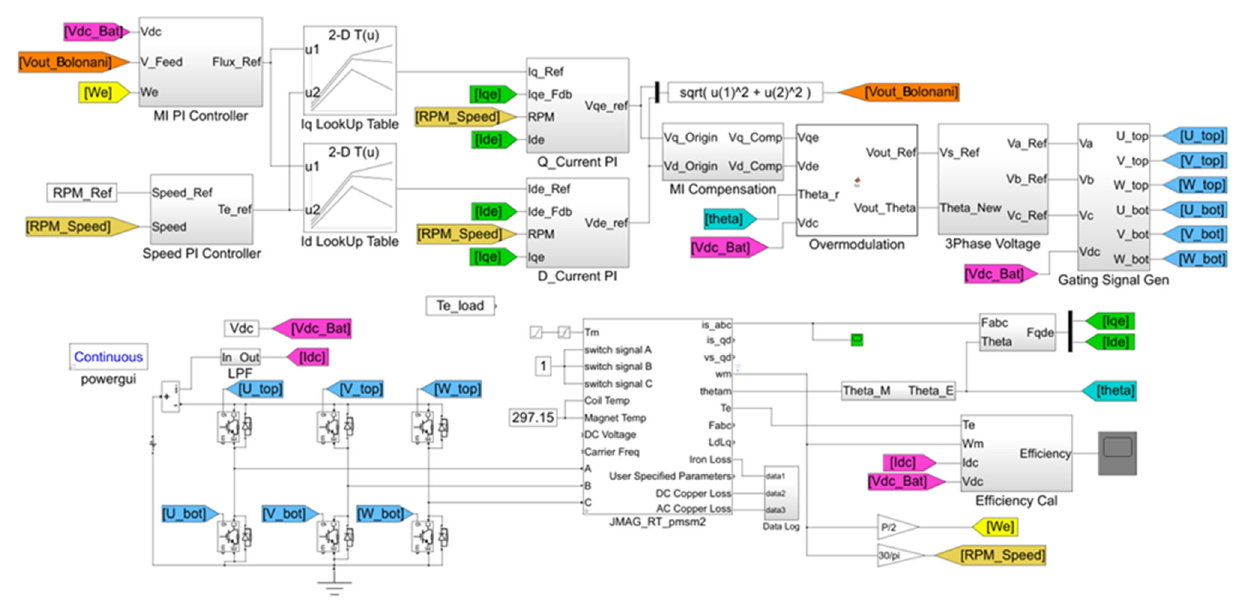
Figure 8. MATLAB Simulink model block diagram.